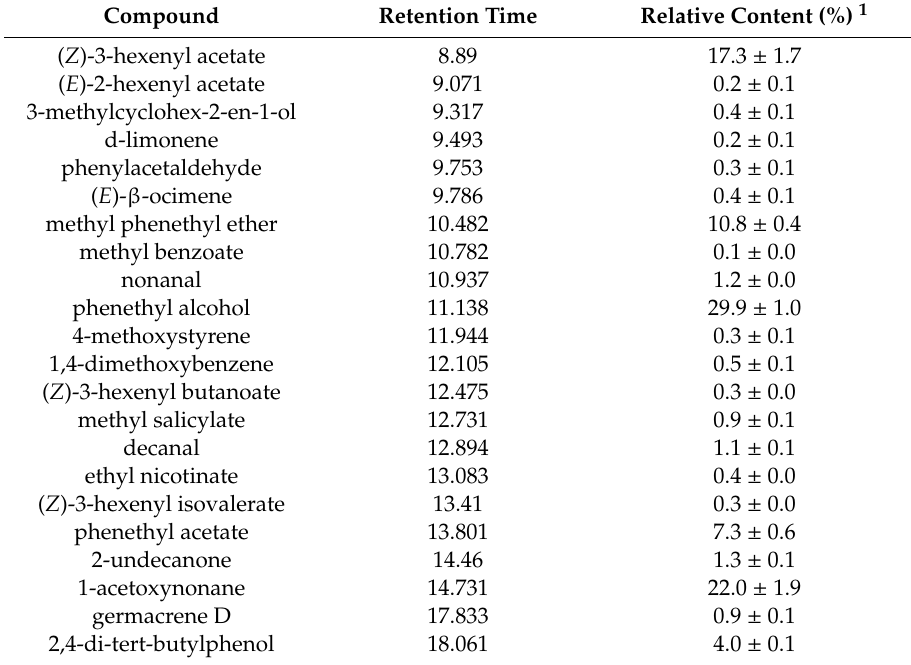
Table 1. Tentatively volatile components of flowering Medicago sativa .